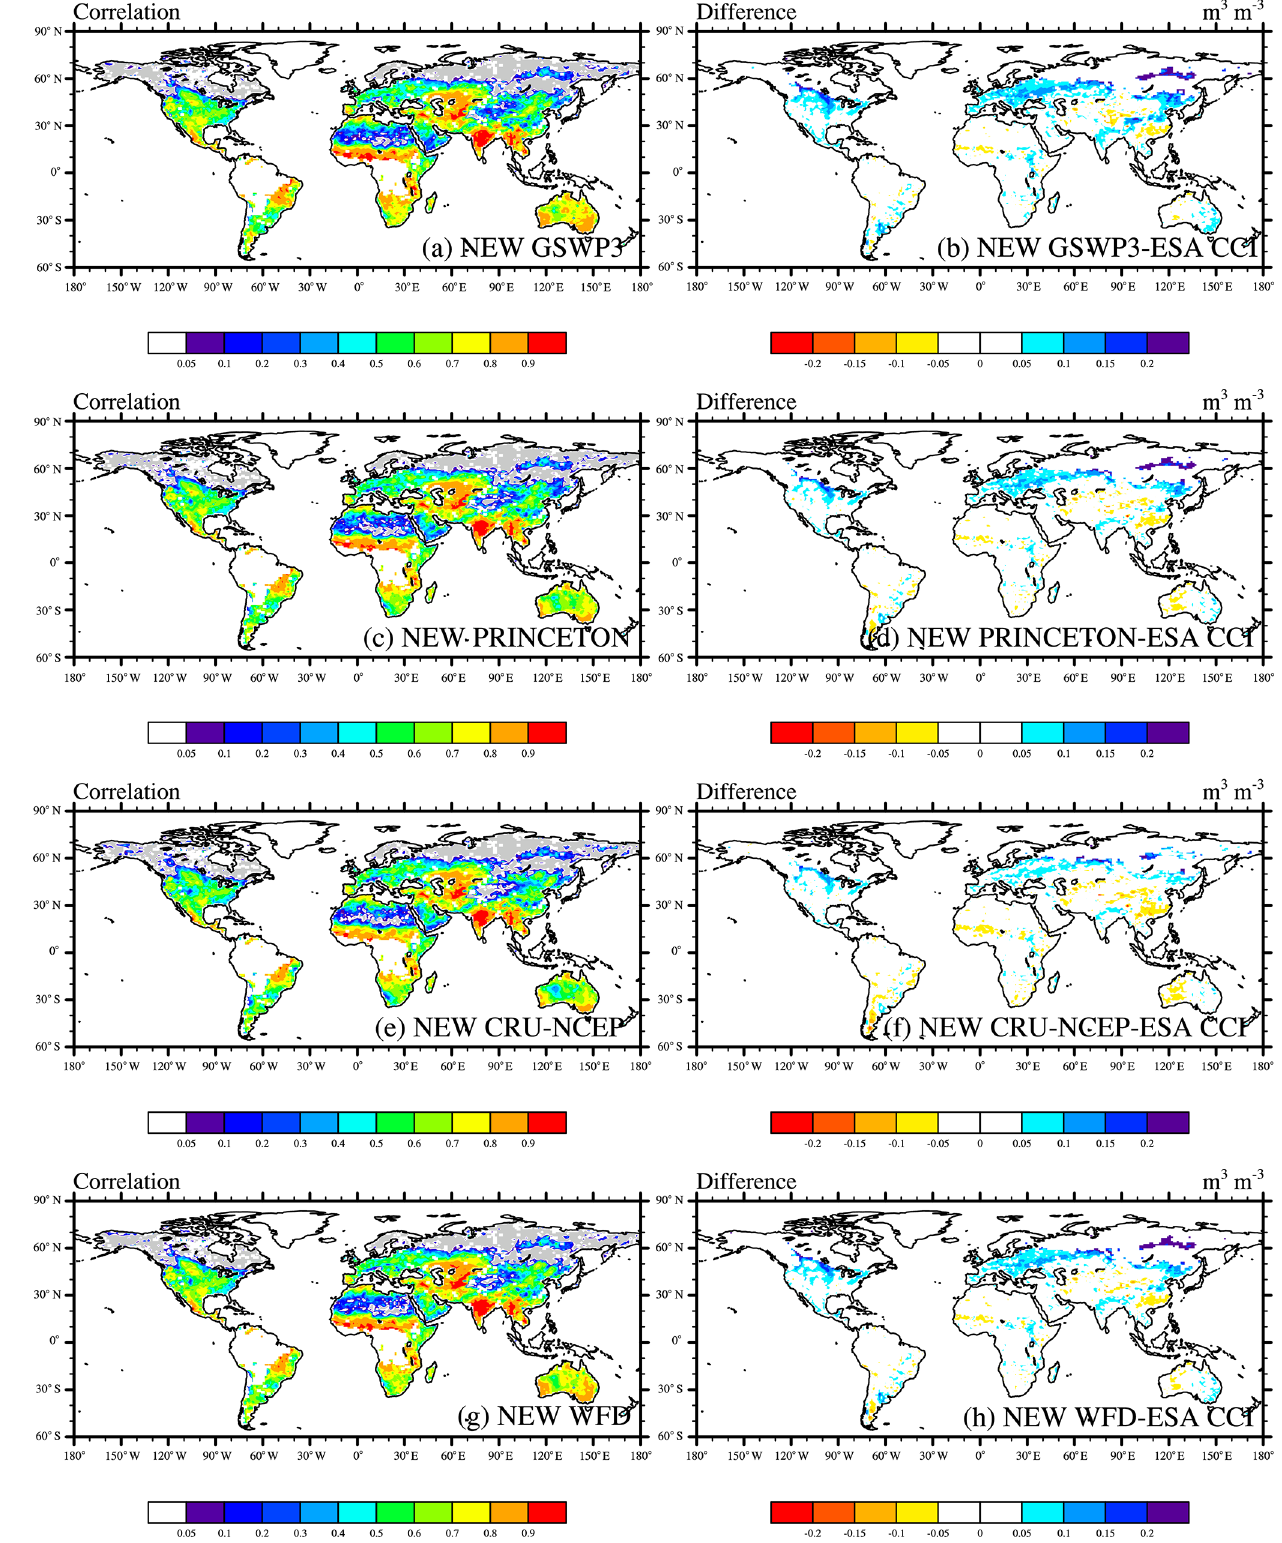
Figure 1. Correlation coefficients (a, c, e, g) and differences in spatial patterns (b, d, f, h) of the ESA-CCI soil moisture and the corresponding simulated top 10cm soil moisture from 1979 to 2010. Gray pixels indicate no correlation and negative correlation.